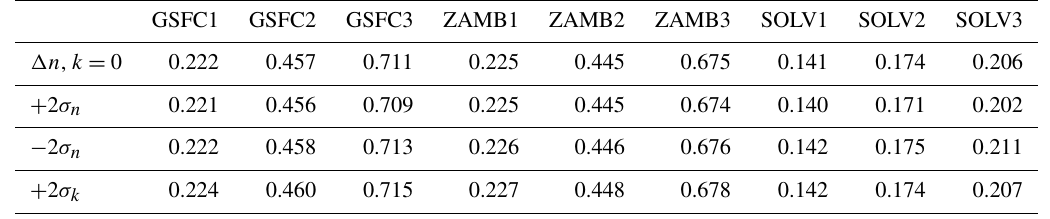
Table 11. Fine-mode aerosol optical depth at 500nm ( τ f ( 500 ) ) obtained varying the refractive index by ± 2 σ during the retrieval process. The value of 2 σ n is spectrally independent and equal to 0.02 for GSFC and ZAMB, but is equal to 0.06 for SOLV. For the imaginary part, 2 σ k is also spectrally independent and has values of 0.008, 0.006 and 0.002 for ZAMB, GSFC and SOLV respectively. Note that k − 2 σ k produces negative values of k for all wavelengths in the aerosol example GSFC and for some in SOLV. In those cases, k is fixed as zero in the retrieval.